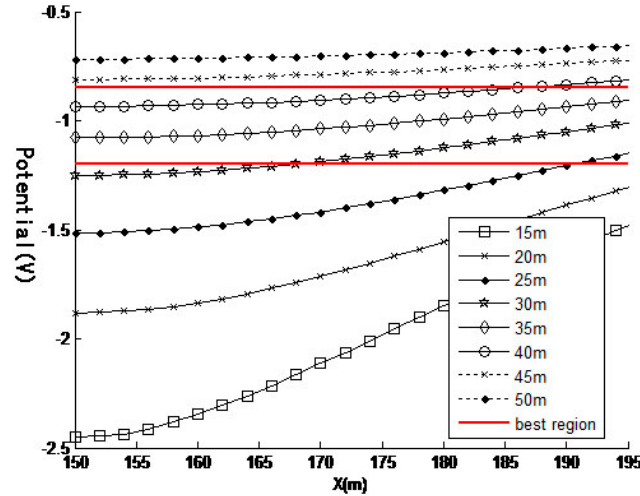
Figure 5. Ground potential distribution caused by different positions when the anode potential is 90V.